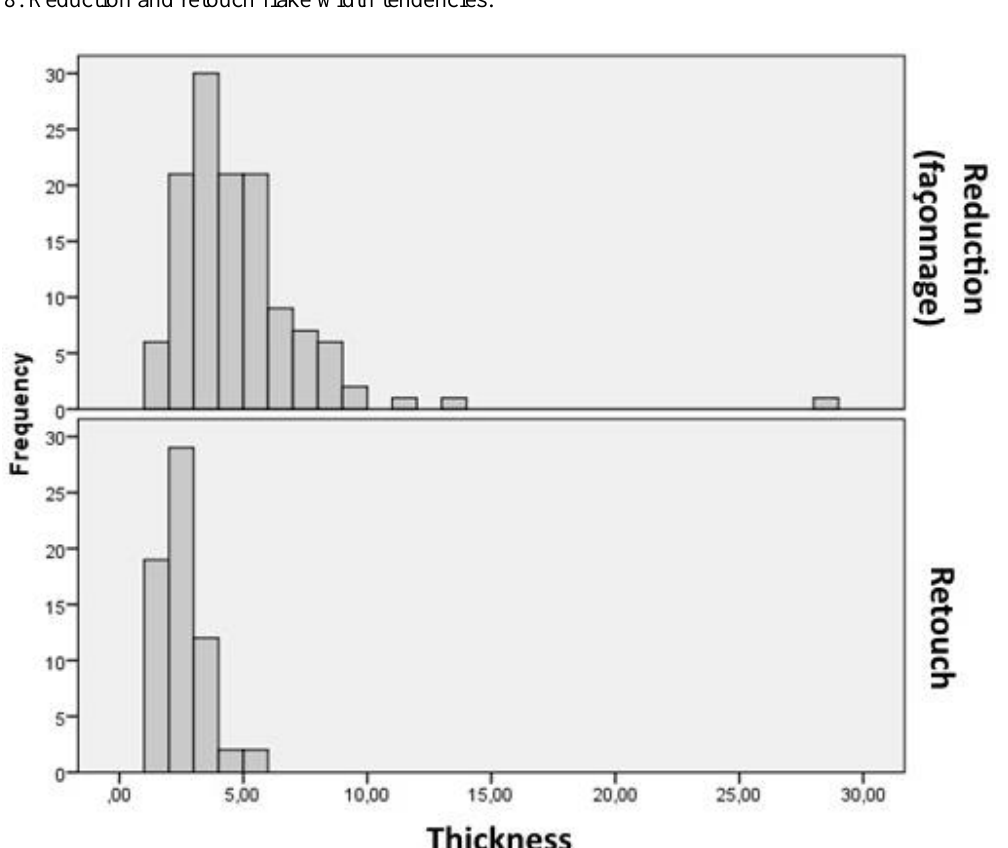
Figure 9. Reduction and retouch flake thickness